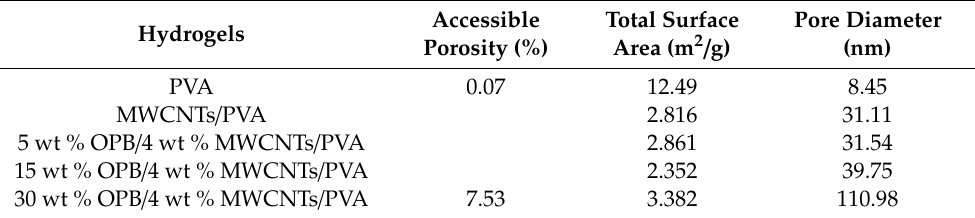
Table 2. Pore characteristics of